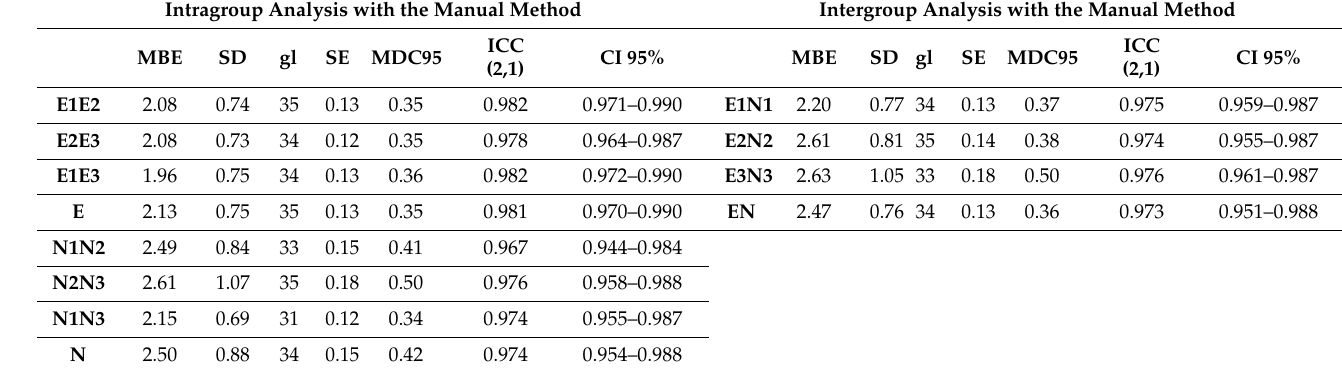
AXBY is the distribution of errors between the measurements of experience groups A and B in tests X and Y. E stands for experts and N for novices. MBE is the mean bias error, SD is the standard deviation, gl is the number of sample measurements (gl = 35 − outliers), SE is the standard error of the sample, MDC95 is the minimum detectable change (in degrees), ICC (2,1) is the intra-class correlation coefficient of absolute concordance, and CI 95% is the 95% confidence interval.